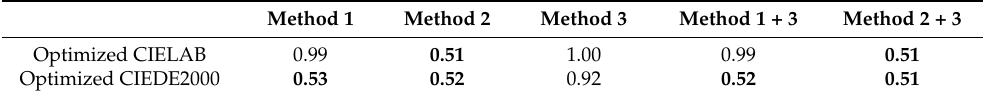
Table 4. F -test values of the optimized CIELAB and CIEDE2000 formulas with respect to the original ones for visual results from Experiment I. Bold numbers indicate cases with statistically significant im-